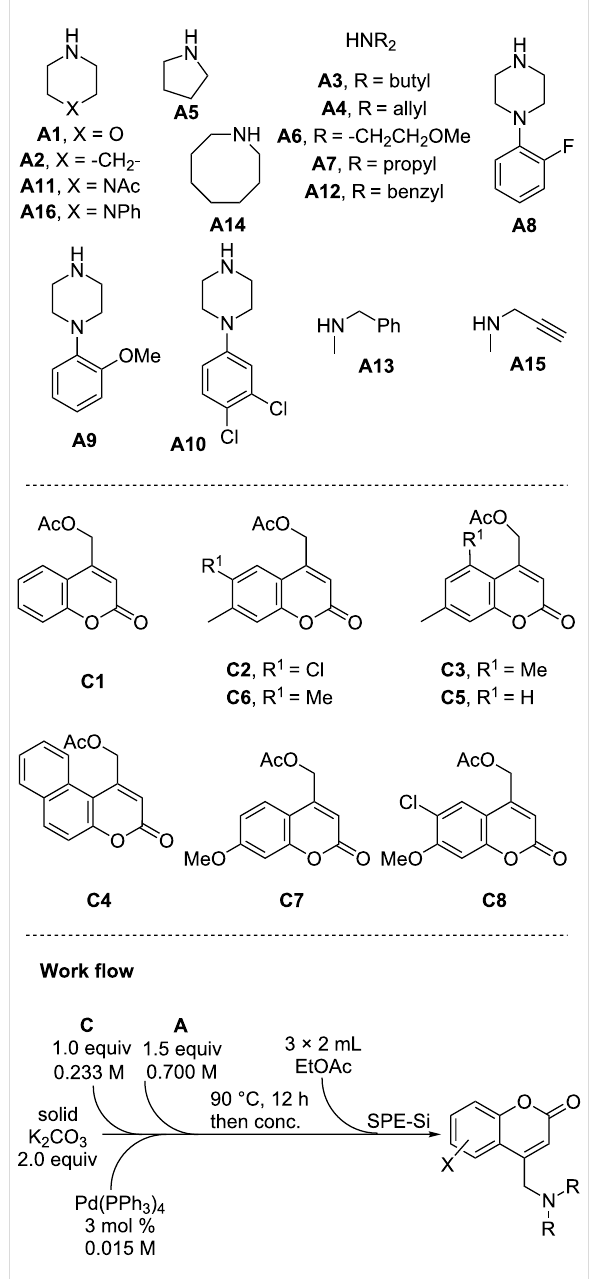
Figure 2: Library planning for amine ( A ) and coumarin ( C ) coupling